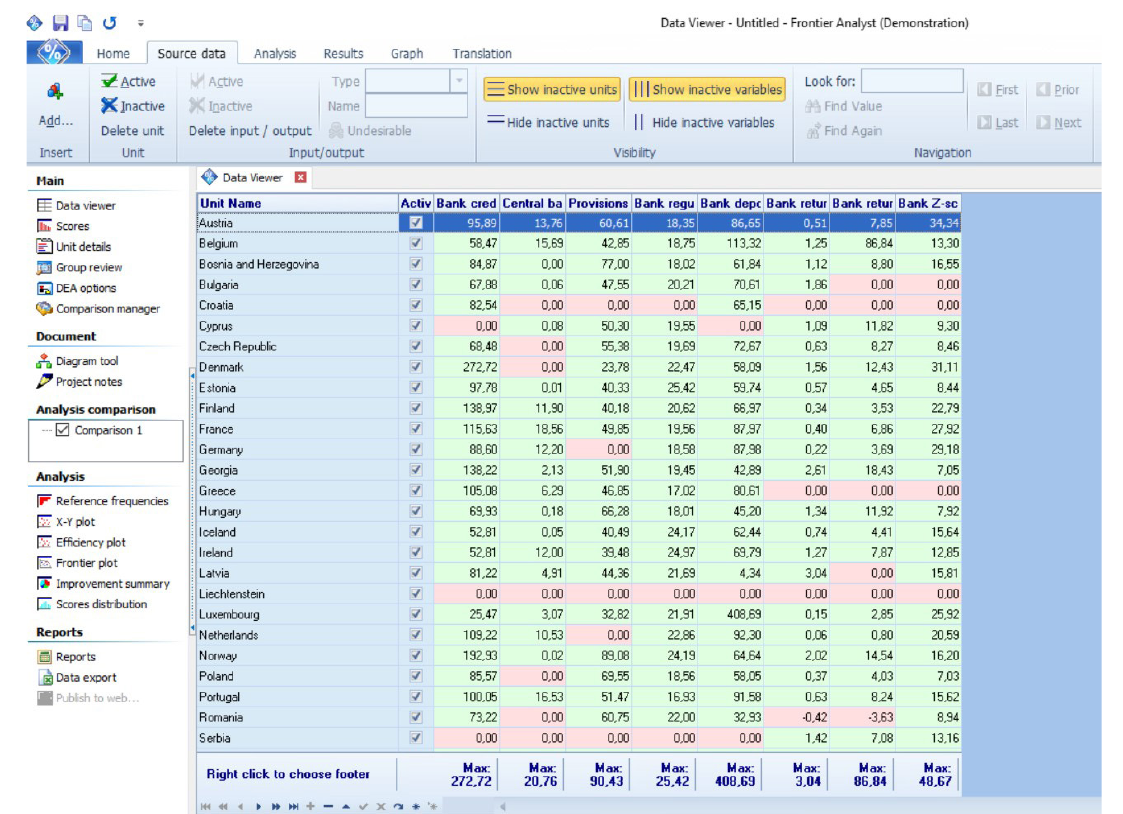
Figure 2. Input of basic data for assessing the efficiency of the banking